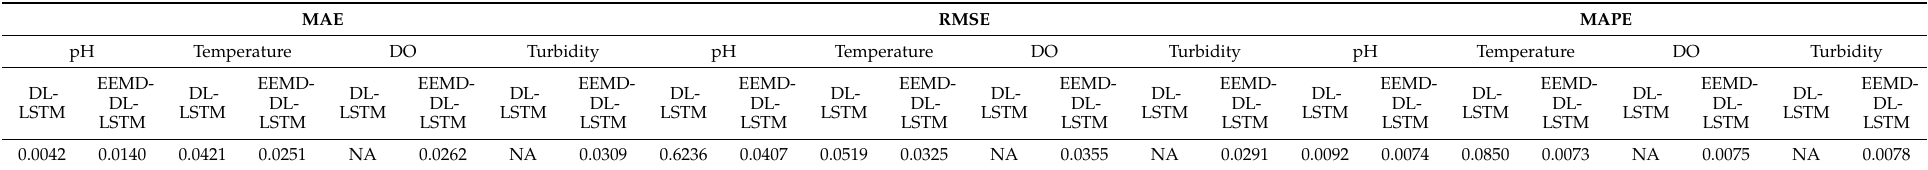
Table 2. Comparison of prediction accuracy for individual water quality parameters against a similar model x . Not applicable (NA) is used in this table because the reference model [2] did not include error statistics for DO and turbidity in their paper. x DL-LSTM model [2] and our proposed novel hybrid EEMD-DL-LSTM NN prediction model.